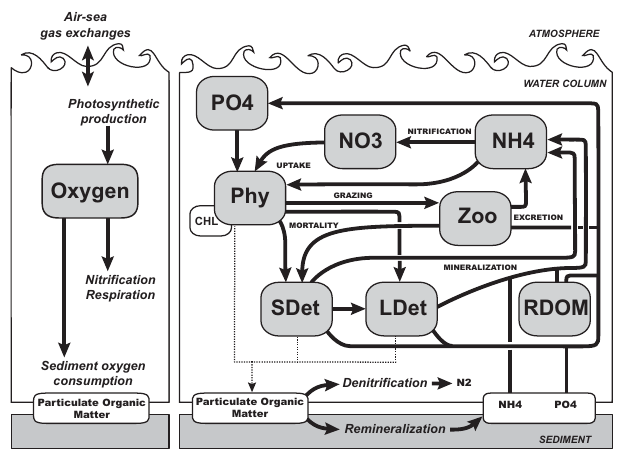
Figure 3. Schematic of the biological model.